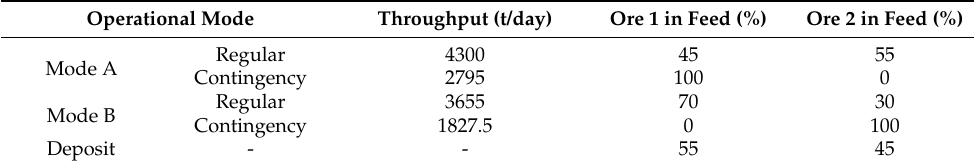
Table 4. Description of operational modes in relation to deposit